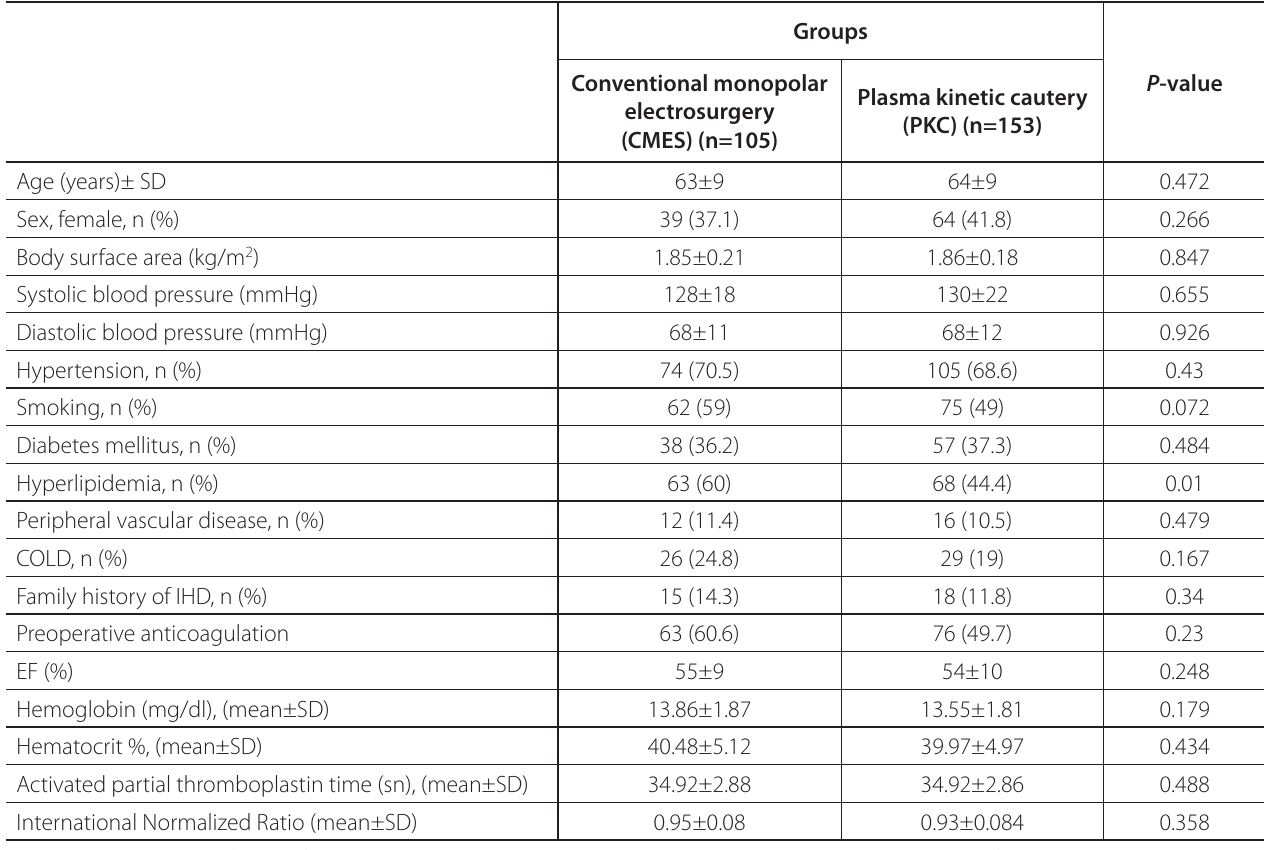
Table 1 . Patients’ preoperative demographic